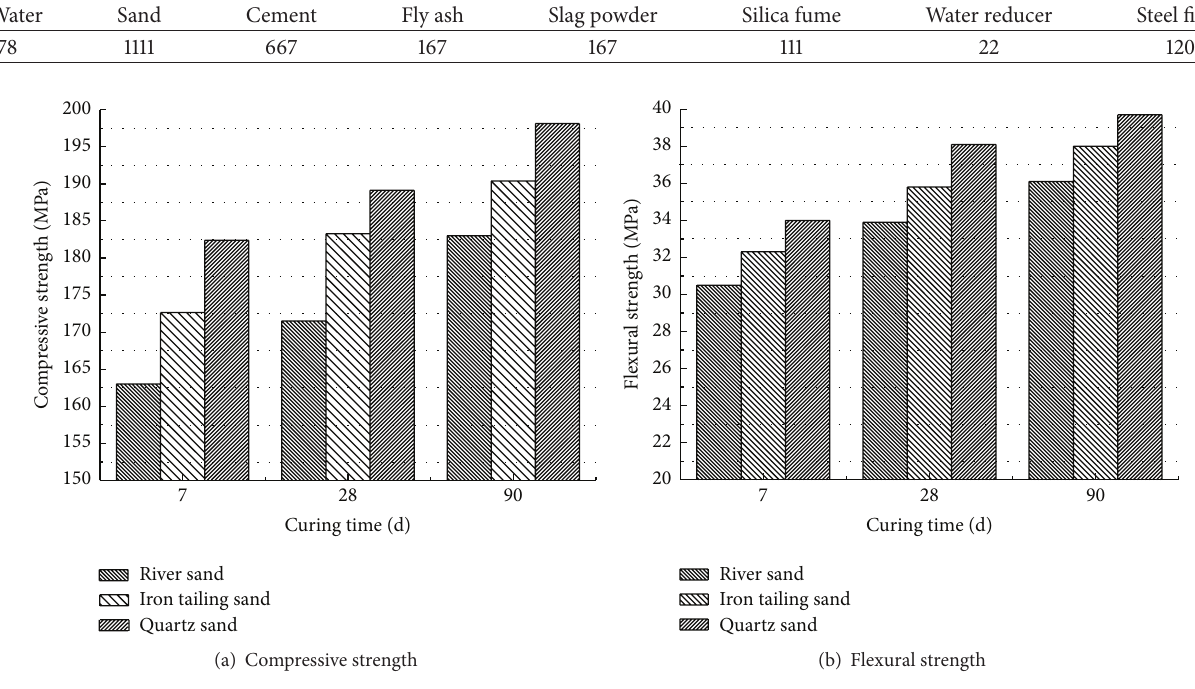
Figure 3: The influence of different sands on